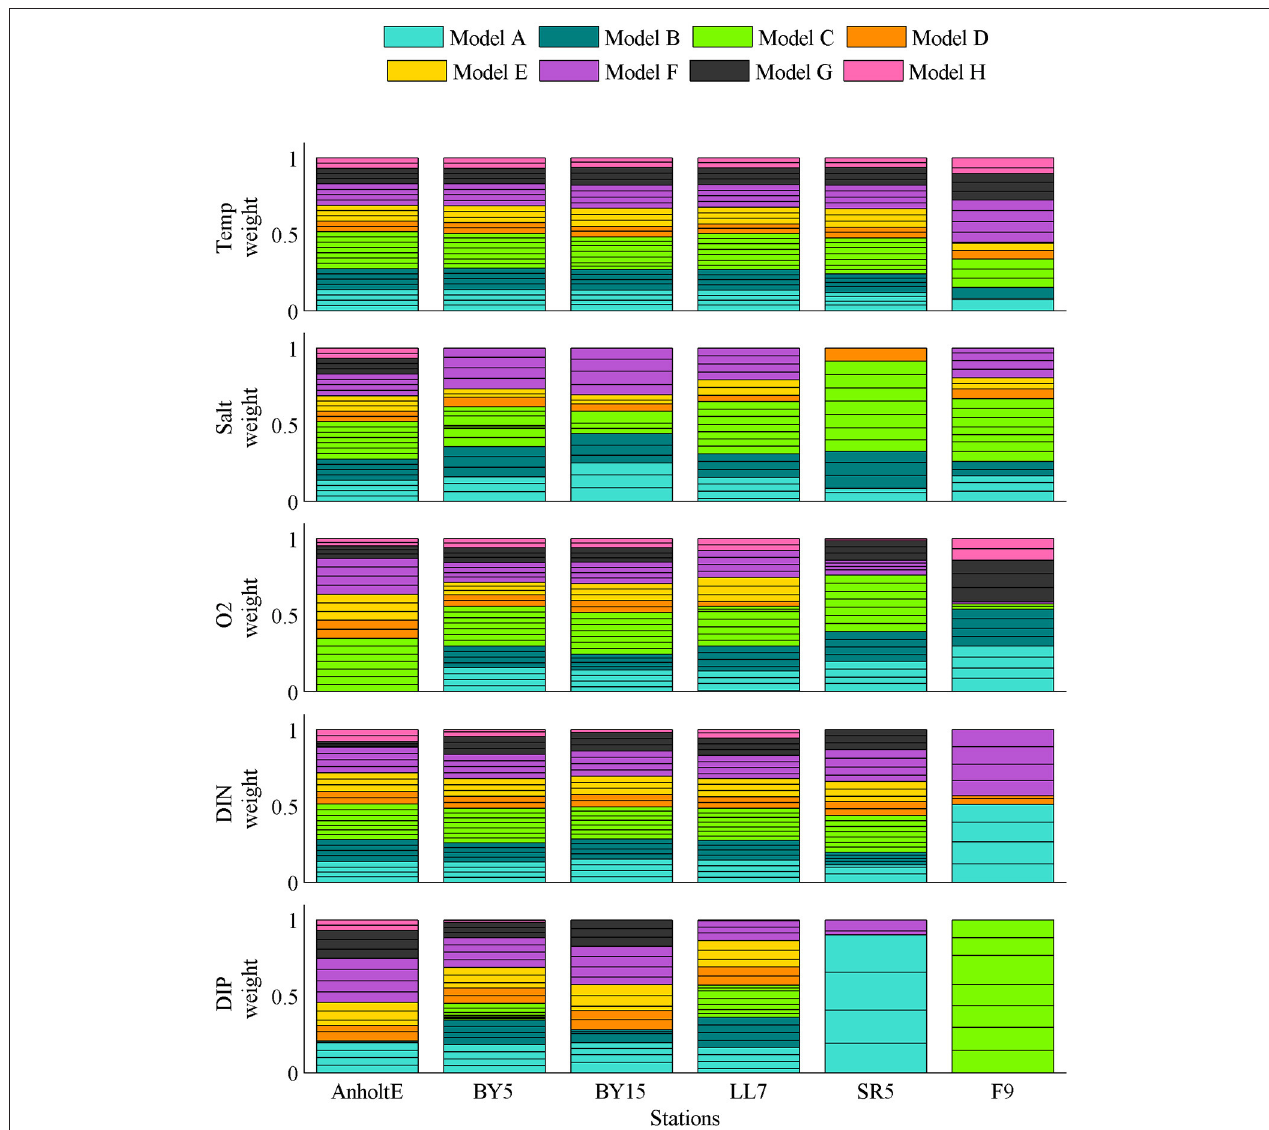
FIGURE 6 | Weights (Equation 5) for each variable, station and scenario simulation of Model A to